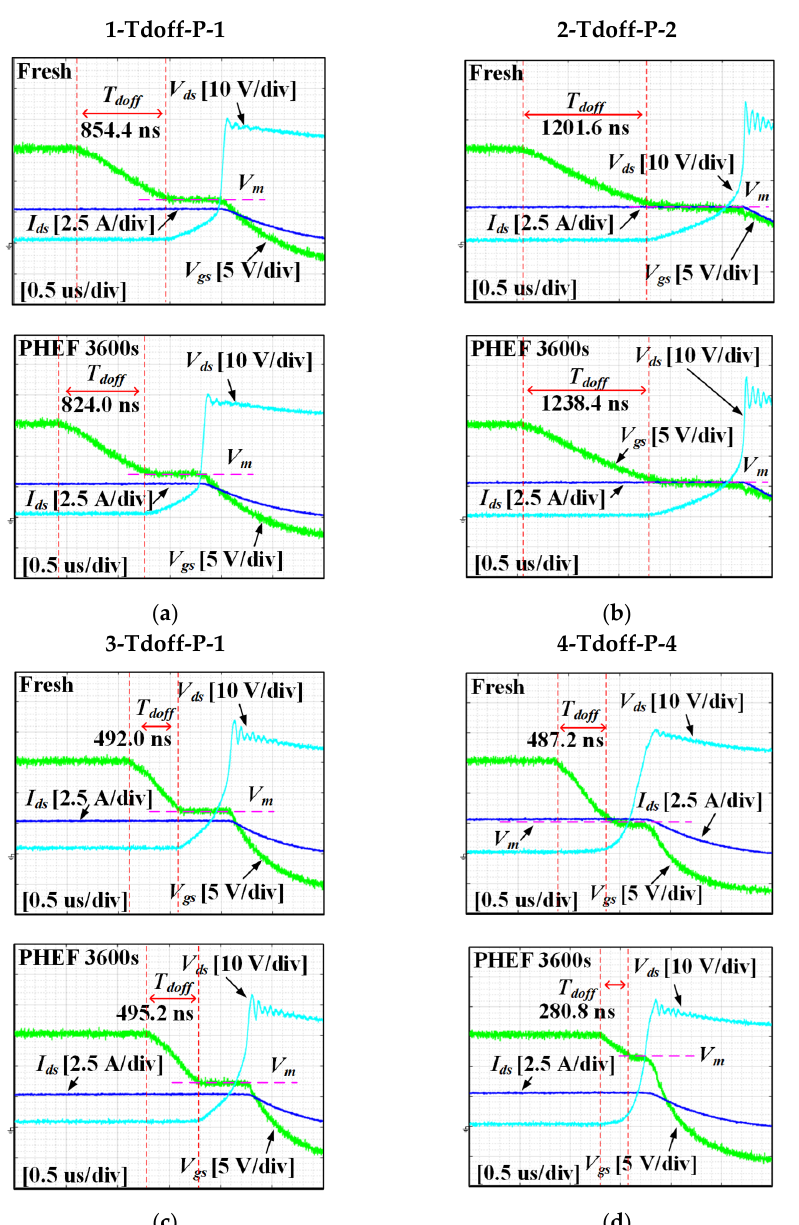
Figure 16. Turn off waveforms in PHEF stress: ( a ) 1-Tdoff-P-1, ( b ) 2-Tdoff-P-2, ( c ) 3-Tdoff-P-1, and ( d ) 4-Tdoff-P-4.